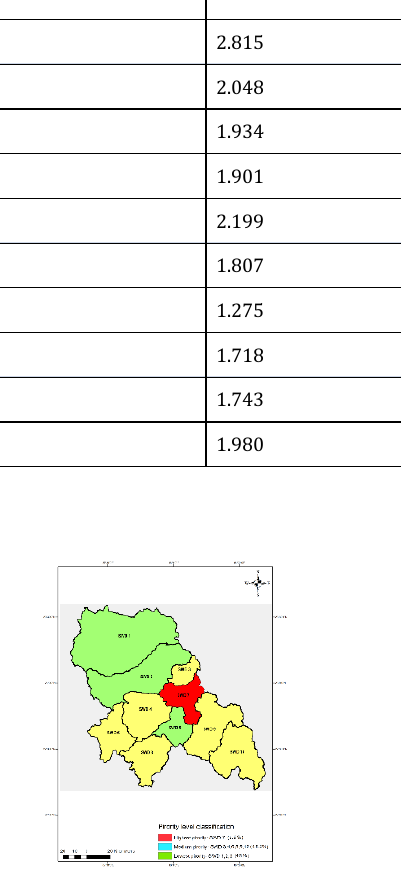
Figure 5 : Zonation map of upper watershed of River Subarnarekha